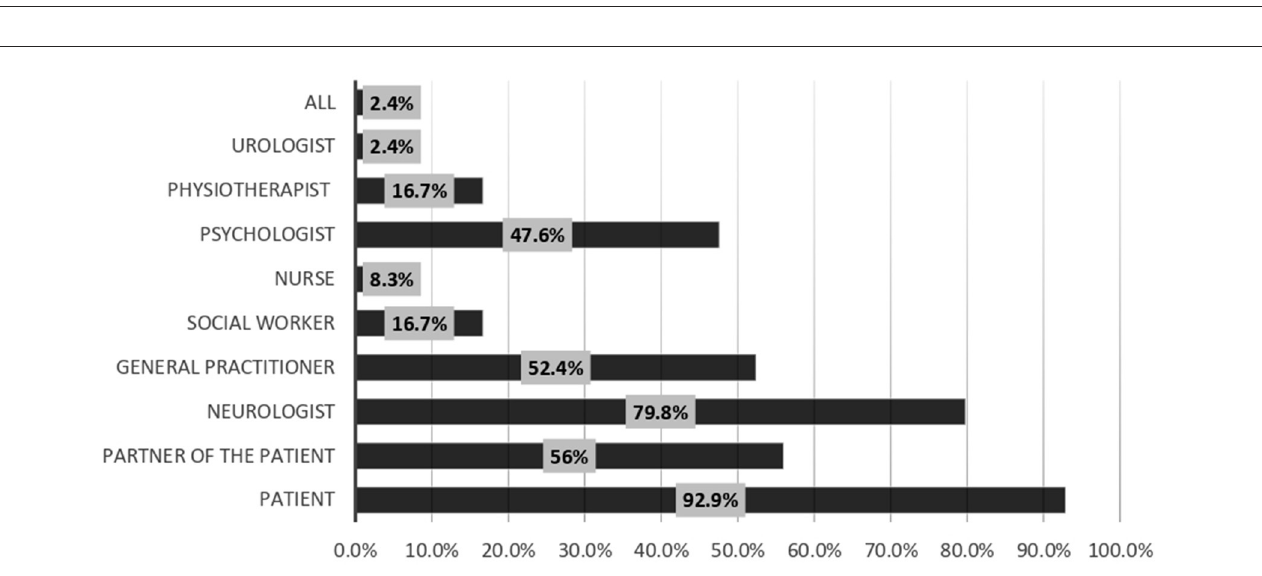
FIGURE5 According to you, who is responsible for discussing